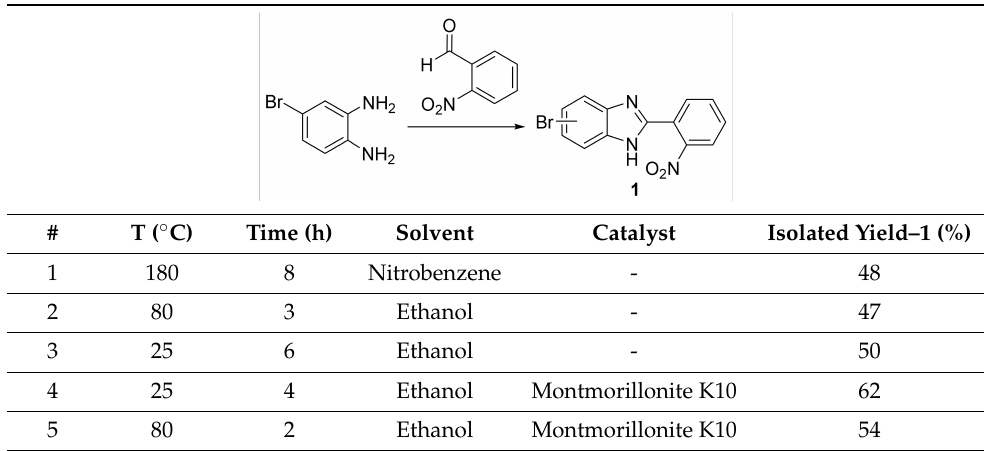
Table 2. Optimization of the reaction conditions for the condensation reaction between 4-bromo-1,2- diaminobenzene and 2-nitrobenzaldehyde (a)